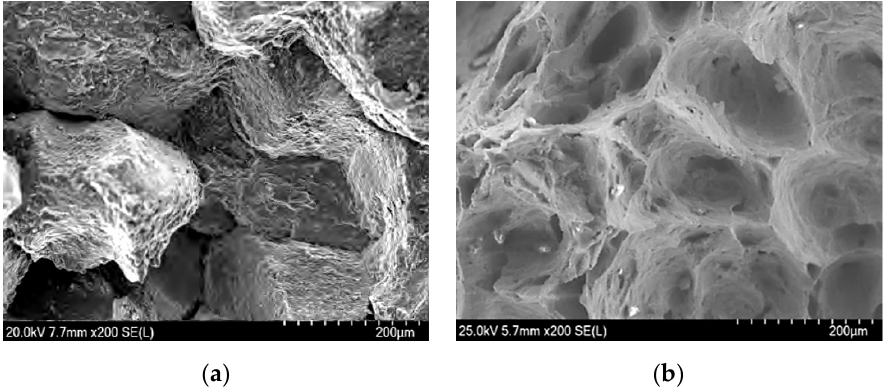
Figure 8. Comparison of fracture appearance of tensile specimens before and after magnesium treatment (780 °C). ( a ) Before magnesium treatment. ( b ) After magnesium treatment.